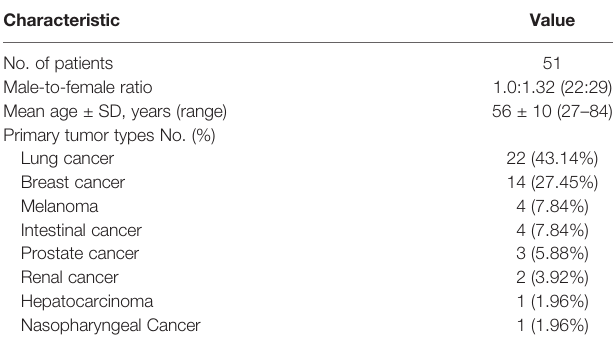
TABLE 2 | Clinical Characteristics of Participants for Comparison Study between 68 Ga-P15-041 PET/CT and 99m Tc-MDP WBBS. Characteristic